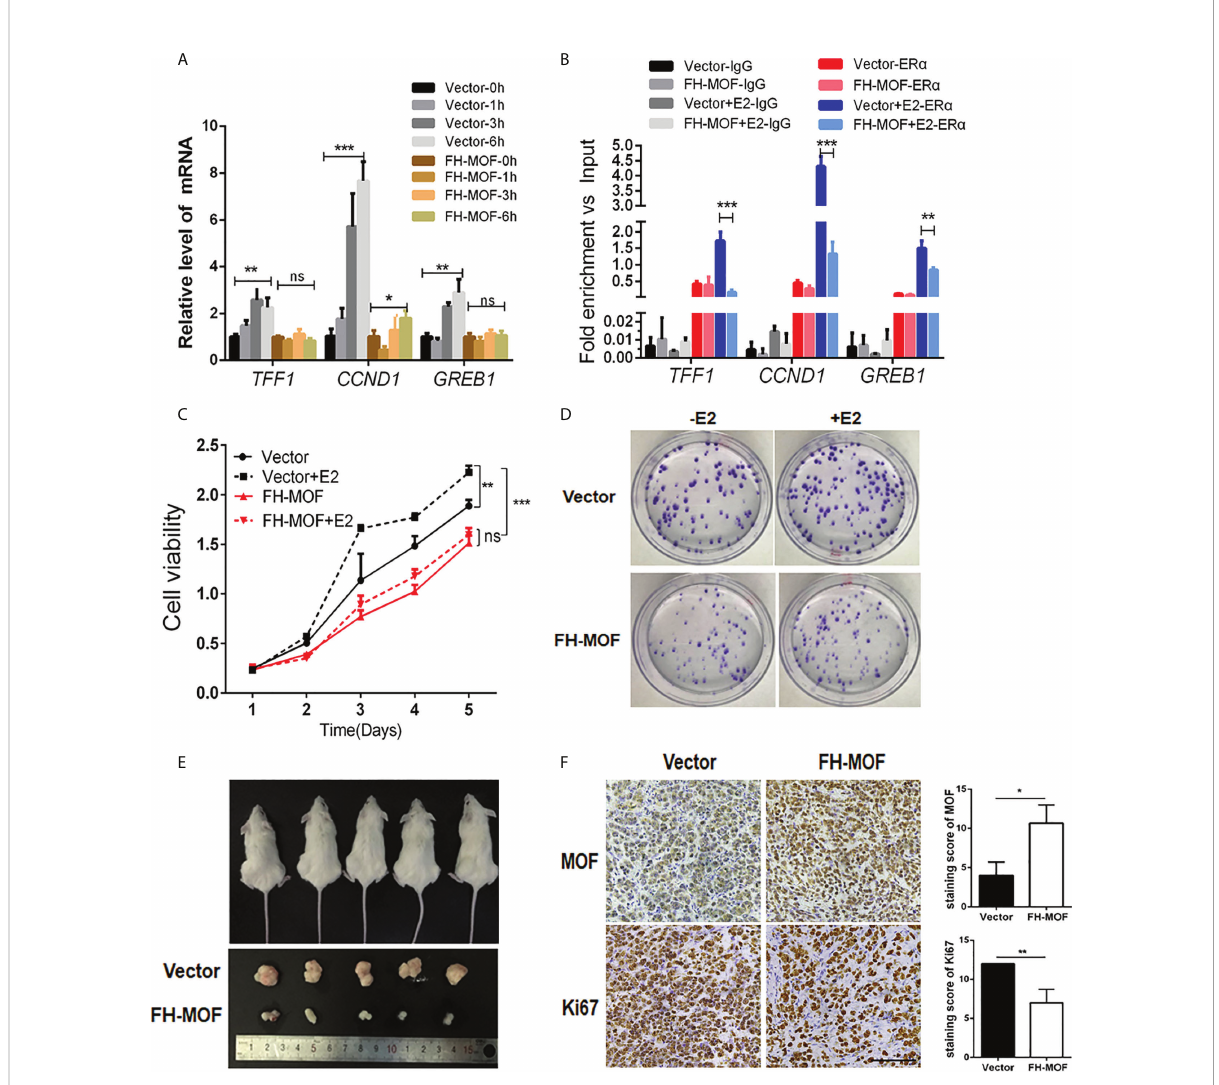
FIGURE 3 The inhibitory roles of MOF in ER a signaling, cellular proliferation, and tumorigenicity of BC cells. (A) The effects of MOF overexpression on ER a -mediated transcription activity of target genes (TFF1, CCND1, and GREB1) by qRT-PCR assay in E2-treated MCF7 cells. (B) The recruitment of ER a on the promoters of TFF1, CCND1, and GREB1 was analyzed by ChIP assay in MOF-overexpressed MCF7 cells under E2 stimulation. (C) Cell proliferation of MCF7 was prohibited by ectopic expression of MOF in CCK8 assay. (D) MOF restrained the colony formation ability of MCF7 cells whatever E2 is present. (E) Xenograft tumor-forming assay was conducted to determine the effect of MOF on in vivo tumorigenicity of MCF7 cells. MCF7 cells with stable MOF transfection or control were subcutaneously injected into one fl ank of each mice. Tumors were dissected from mice after 3 weeks of injection. (F) IHC staining (left) and staining score (right) showed the reduced expression of proliferation marker Ki67 in xenograft tumor tissue with MOF overexpression. Bar = 100 m m. ***P < 0.001, **P < 0.01, and *P < 0.05 vs. control group. ns, not signi fi cant vs. control. MOF restrained the colony formation ability of MCF7 cells, whatever E2 is